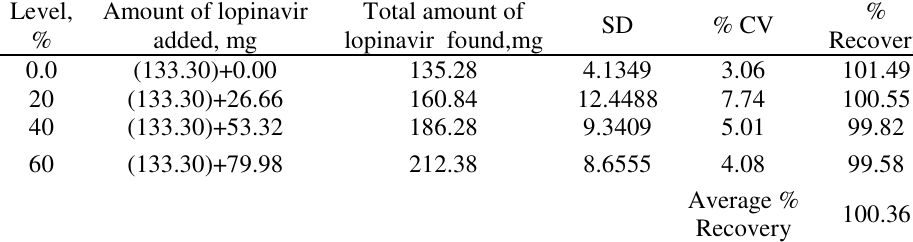
Table 3 . Results from recovery analysis for lopinavir (n=5)